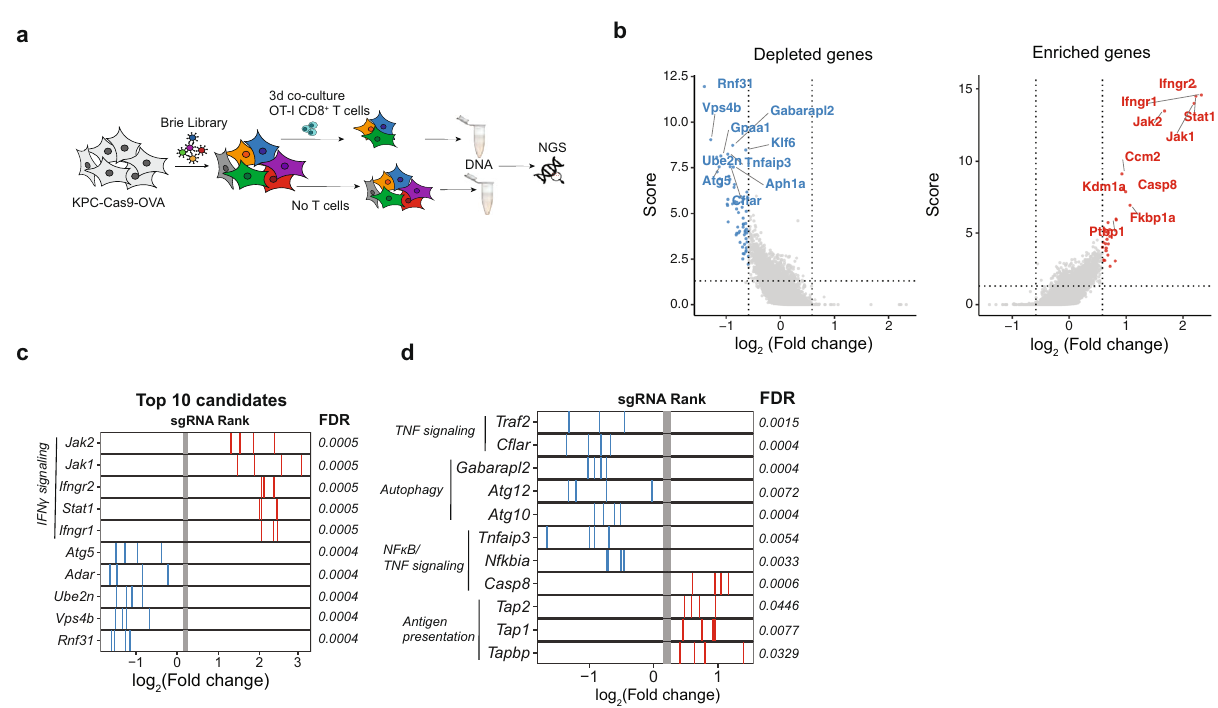
Fig. 1 Genome-wide CRISPR screen in PDA cells reveals immune evasion mechanisms in vitro. a Schematic of genome-wide in vitro CRISPR screen. b Volcano plot of top ten depleted (blue) and enriched (red) genes. Screening analysis was performed with MaGeCK RRA. c sgRANK of the top (red) and bottom (blue) fi ve depleted genes are represented. Gray bars represent non-targeting sgRNAs. d sgRANK of the enriched (red) and depleted (blue) genes of different immune evasion pathways. Gray bars represent non-targeting sgRNAs. MaGeCK RRA analysis can be found in Supplementary Table 1. The genome-wide CRISPR screening data shown were derived from three independent biological replicates ( n = 3).